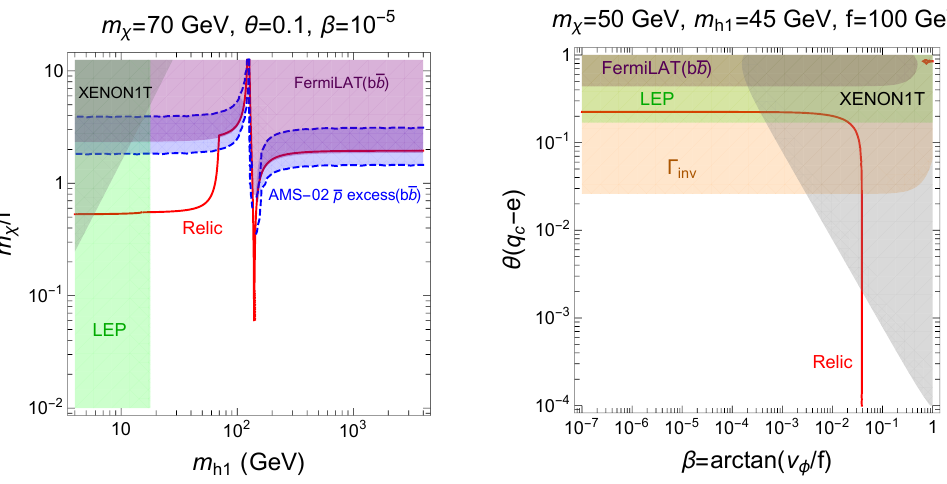
Figure 3 . (Left) Parameter space for m χ /f vs the singlet-like scalar mass. We chose m χ = 70 GeV , θ = 0 . 1 and β = 10 − 5 . (Right) Parameter space for the Higgs mixing angle, θ ( q c − e ) vs the pseudo- scalar VEV, β = arctan( v φ /f ) . We chose m χ = 50 GeV , m h = 45 GeV , f = 100 GeV . The relic 1 density is saturated along the red line. The gray and green regions are excluded by XENON1T and LEP, respectively. Purple region is disfavored by diffuse gamma-rays from Fermi-LAT dwarf galaxies ( b ¯ b ). We also show the blue region favored by the AMS-02 anti-proton excess on left and the orange region disfavored by the bound from the Higgs invisible decay on